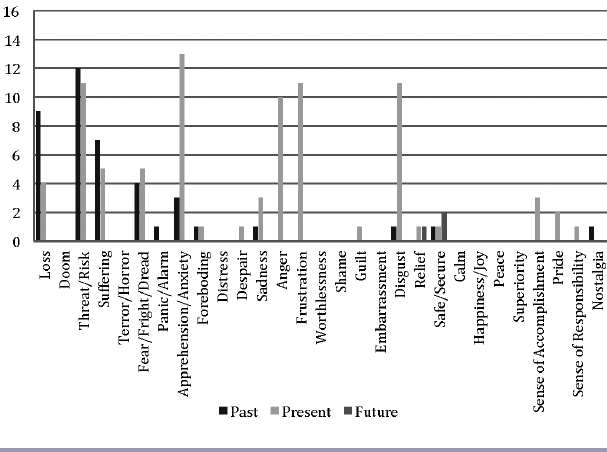
Fig. 6. Total emotion counts between 30 May 2002 and 31 December